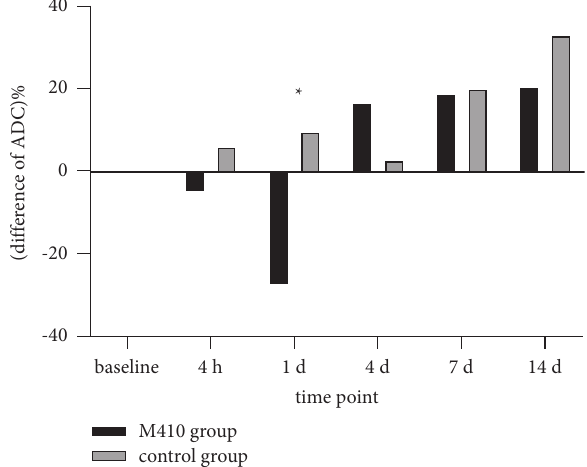
Figure 5: Comparison of the difference in the apparent diffusion coefficient ( Δ ADC%) of the tumor between the two groups at different time points. There was a decrease-increase course for Δ ADC% in the M410 group and an increase-decrease-increase course in the control group, as shown by the images above. The Δ ADC% in the M410 group was significantly lower on day 1 than that in the control group. There was a significant difference in the Δ ADC% between the two groups. ( ∗ P � 0 . 046).